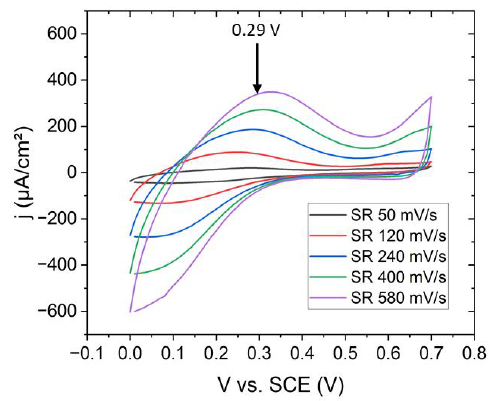
Figure 1. Cyclovoltammetric curves at different scan rates on Au/Cr/Si(100) substrates for the deposition of NaFeHCF.